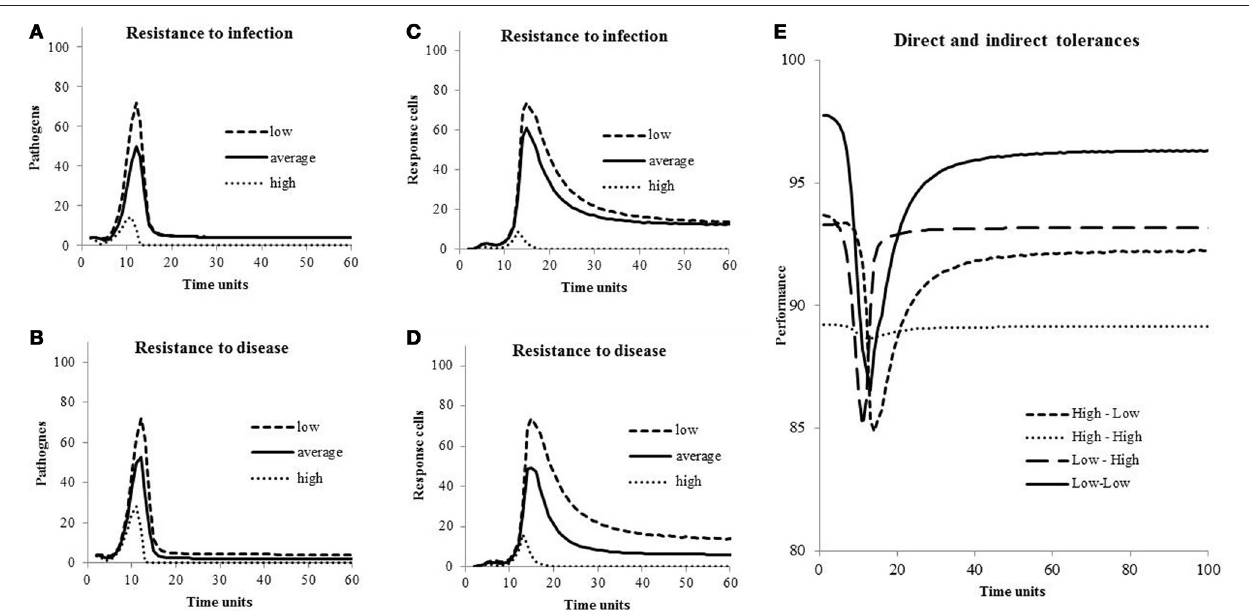
FIGURE 3 | Concentrations of pathogens and response cells for different levels of resistance to infection and to disease, and host performances for different levels of direct and indirect tolerances. Values of the parameters are in Table 1 .